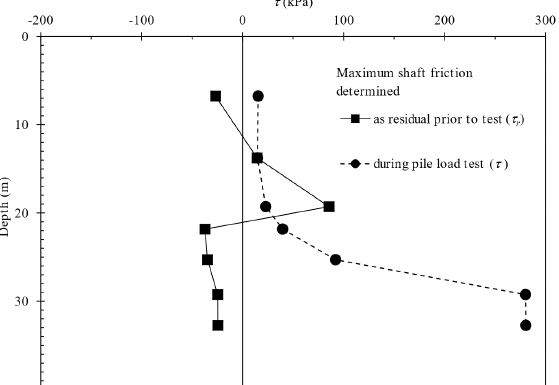
Figure 3. Comparison of residual shaft friction with shaft friction establish from load test for a 1.5 m diameter pile